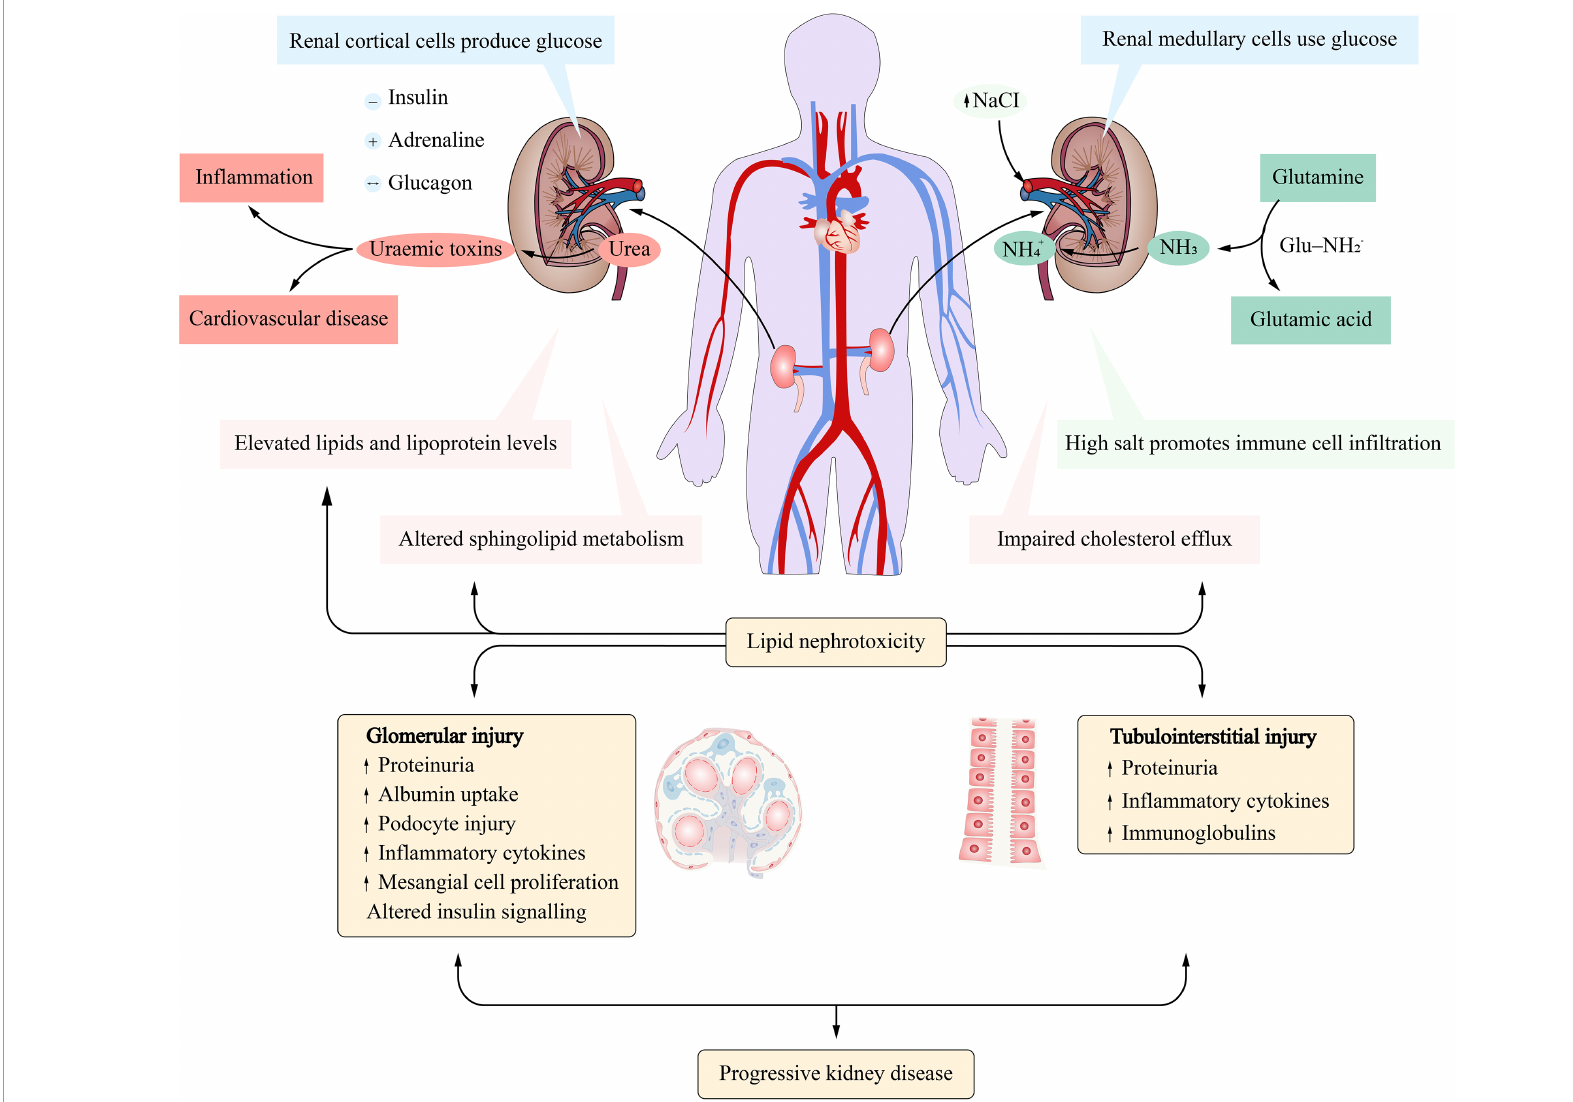
FIGURE 1 | Metabolism of substances in the kidney. Cortical cells undergo gluconeogenesis while medullary cells metabolize glucose. Glutamine is extracted from renal tubular cells and used to produce ammonia (NH3). High levels of urea cause the kidneys to produce uremic toxins. Lipid nephrotoxicity could damage the structure and function of the glomerulus and